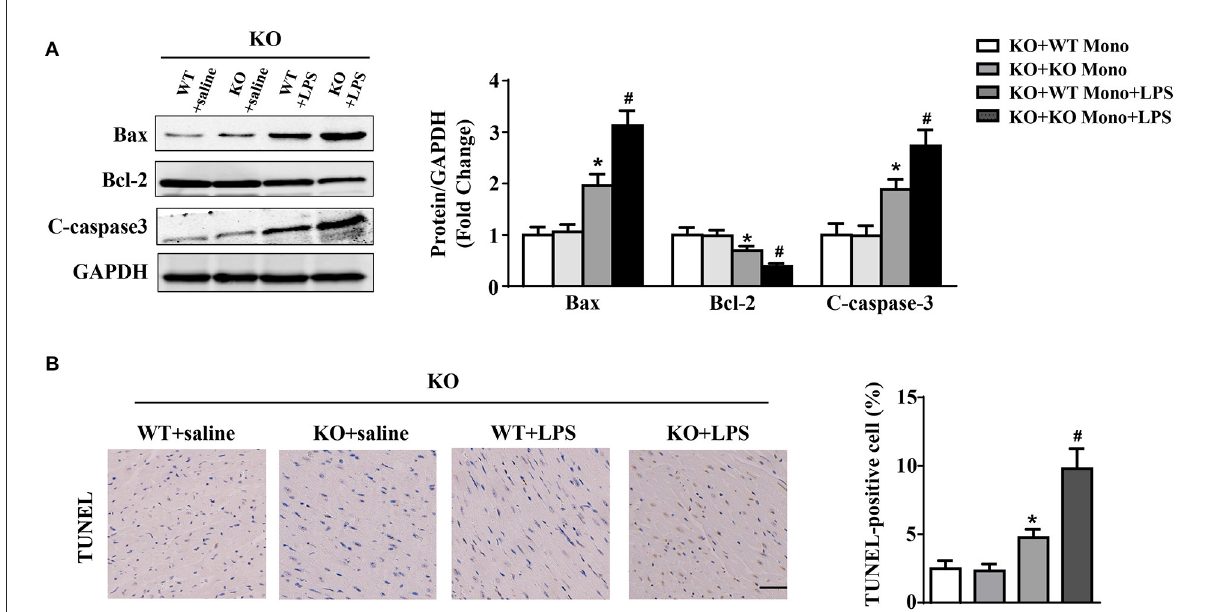
FIGURE7 WT monocyte adoptive transfer alleviates myocardial apoptosis in LPS-treated IL-12p40 − / − mice. (A) Western blot analysis of Bax, Bcl-2 and C-caspase-3 protein levels in heart tissues of each group ( n = 5). (B) TUNEL staining and the quantitative results of heart tissues in each group ( n = 6; scale bar, 50 µ m). * P < 0.05 compared with the KO + WT Mono group. # P < 0.05 compared with the KO + WT Mono + LPS group.